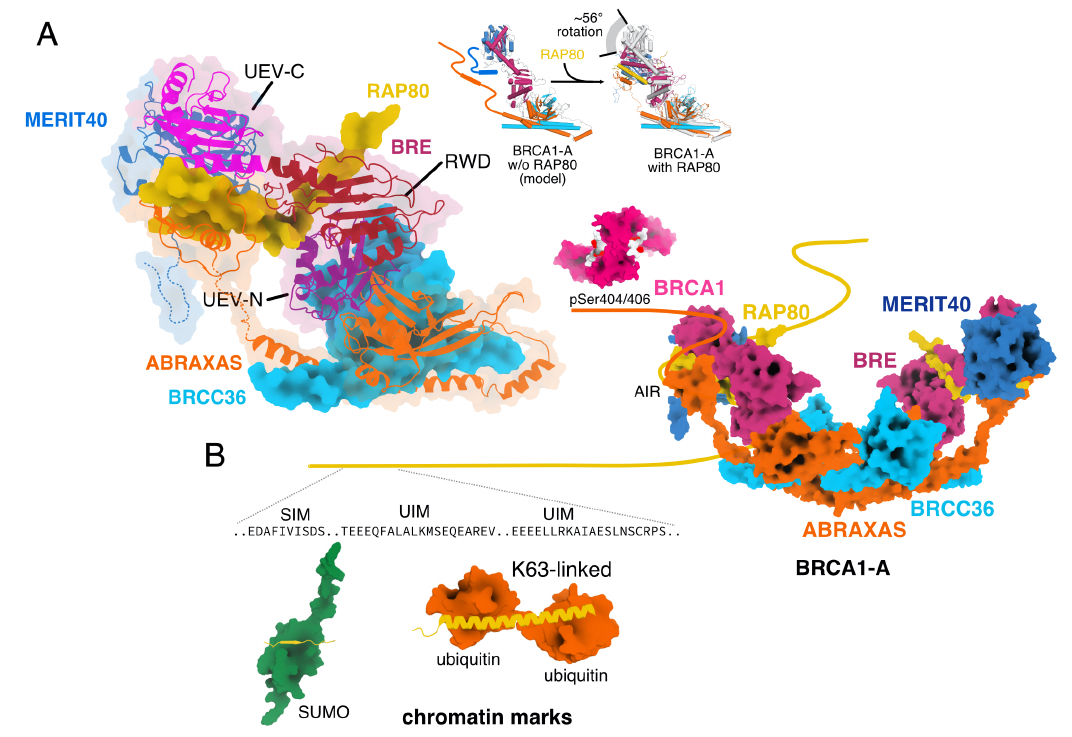
Figure 2. ( A ) Integration of RAP80 into the BRCA1-A complex. RAP80 and BRCC36 are shown as surface representation, ABRAXAS, BRE and MERIT40 are shown as cartoon. Integration of RAP80 into BRCA1-A induces a substantial conformation change in BRE, which results in a rotation of ∼ 56 ◦ towards the coiled coils at the base of the complex (BRCA1-A and BRISC-SHMT2 α structure: [25]). ( B ) Schematic representation of BRCA1-A binding to chromatin marks. The SIM and twin UIM domains at the N-terminus of RAP80 are tethered by a long flexible linker to BRCA1-A. BRCA1 binds to the C-terminus of ABRAXAS (BRCA1-A structure: [25], BRCA1 BRCT domain with bound ABRAXAS phosphopeptide structure: [30], RAP80 SIM-bound ubiquitin structure: [41], RAP80 UIM-bound K63-linked ubiquitin structure: